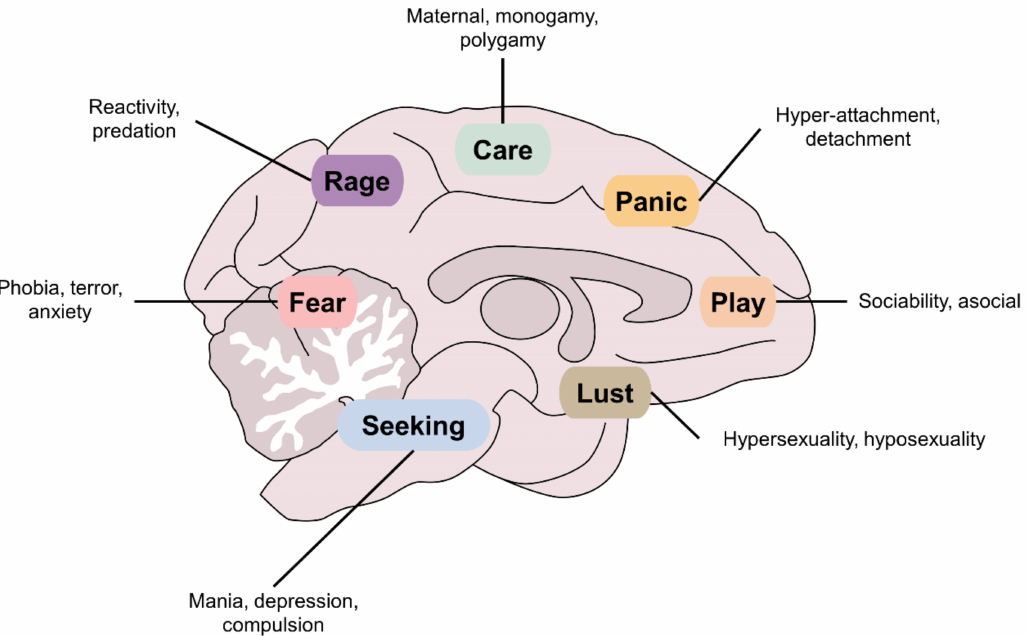
Figure 4. Examples of genetic influence on animal behavior. The basic neurobiological systems represent the phylogenetically robust neural substrate for the expression of behaviors. Selective mating can generate individuals with enhanced sensitivity to a certain kind of stimulation, leading to overexpression of the behavior involved. Likewise, selection can decrease sensitivity to stimuli, thus reducing the probability of a certain behavior being expressed. Those manipulations can be positive or negative to animal